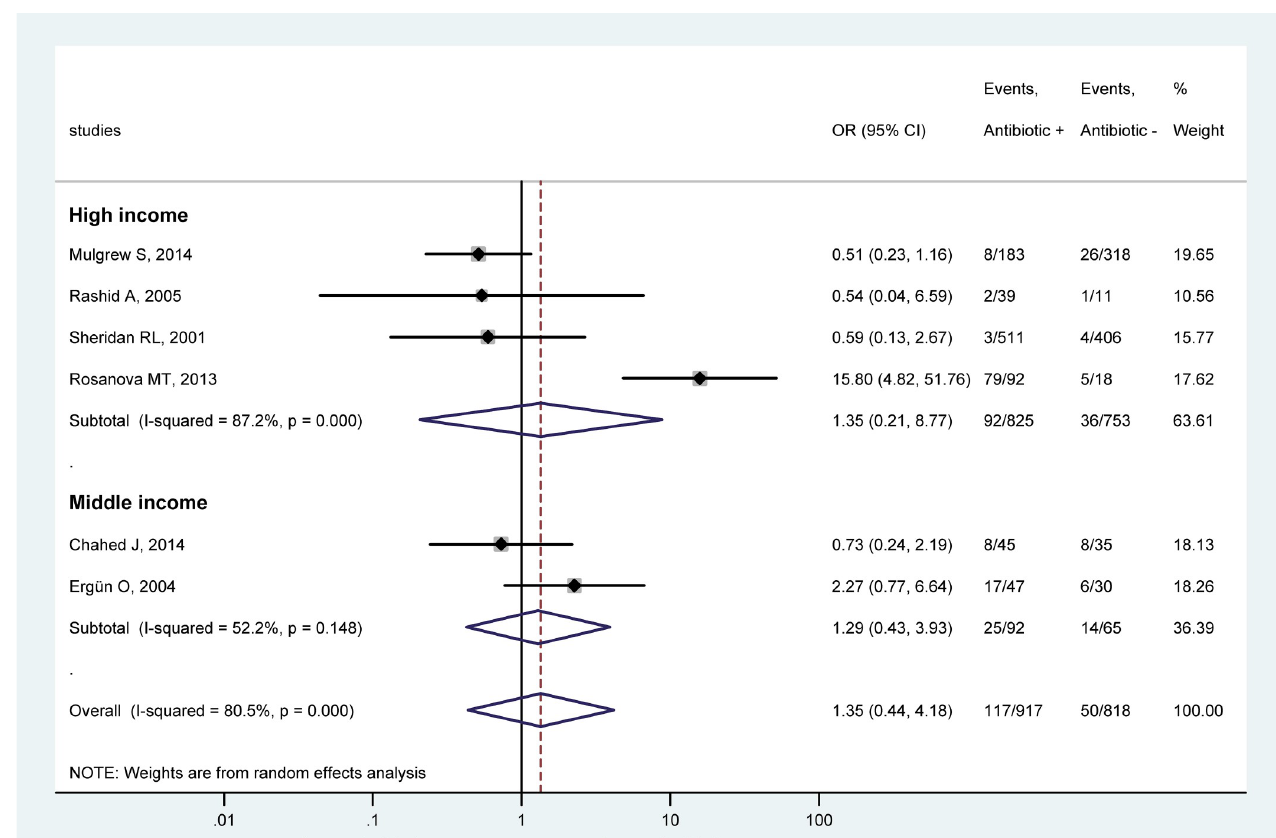
Fig 5. Forest plot of the odds ratios (ORs) for all infectious complications in pediatric patients with burn injuries who received versus those who did not receive systemic antibiotic prophylaxis in country subgroups of high income (top) and middle income (bottom).